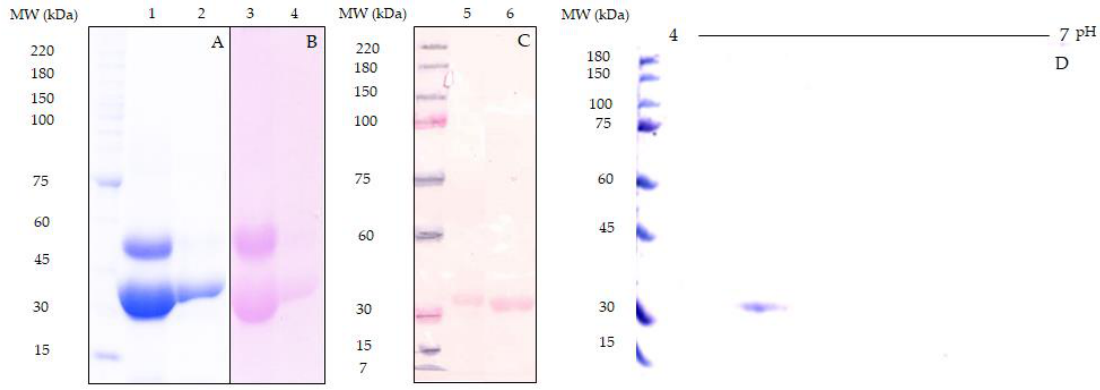
Figure 2. SDS-PAGE profile for the TBL-IE2 fraction. A 10% SDS-PAGE was performed. ( A ) Coomassie staining for TBLF and TBL-IE2 electrophoresis; ( B ) Schiff’s periodic acid staining of TBLF and TBL-IE2; ( C ) Western Blot for TBLF and TBL-IE2; ( D ) two-dimensional electrophoretic profile for TBL-IE2.